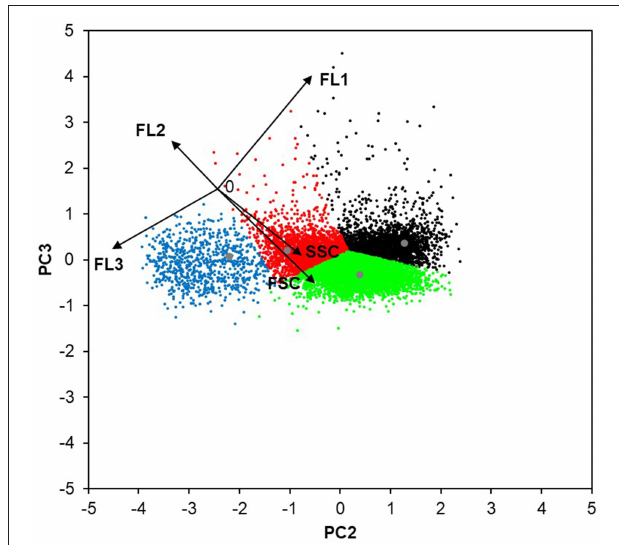
FIGURE 5 | The four sub-populations of P. pastoris cells defined with the use of PCA. The flow cytometric data (FSC, SSC, FL1, FL2, FL3) of 10,000 random cells from the bioreactor cultivations of the strains producing Ec PGA and Ca LB, and the non-producing strain (all at µ methanol 0.016 h − 1 ) were analyzed with PCA. The lowest level of redundancy was observed when the data were displayed as the combination of PC2 and PC3 (describing ∼ 39.8% of the population variability), since the flow cytometric data (black vectors) were the most de-correlated. The length of each vector is 50AU. The combination of PC3 and PC2 was used to establish the clustering method (population centers are displayed in gray). According to the FC signals (black arrows), the identified four clusters can be described as follows: smaller and less complex viable cells with no UPR up-regulation (red); larger and more complex viable cells with no UPR up-regulation (green); viable cells with up-regulated UPR (black); and cells with impaired viability (blue).